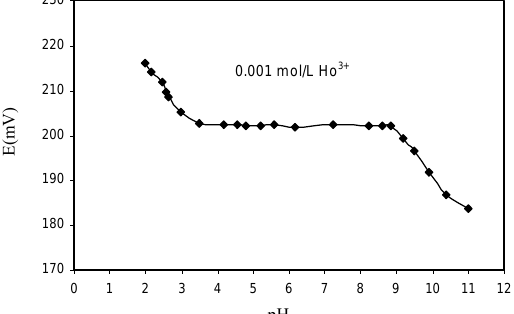
Figure 3. pH effect of the test solution (1.0 × 10 -3 mol/L of Ho 3+ ) on the Ho 3+ sensor based on